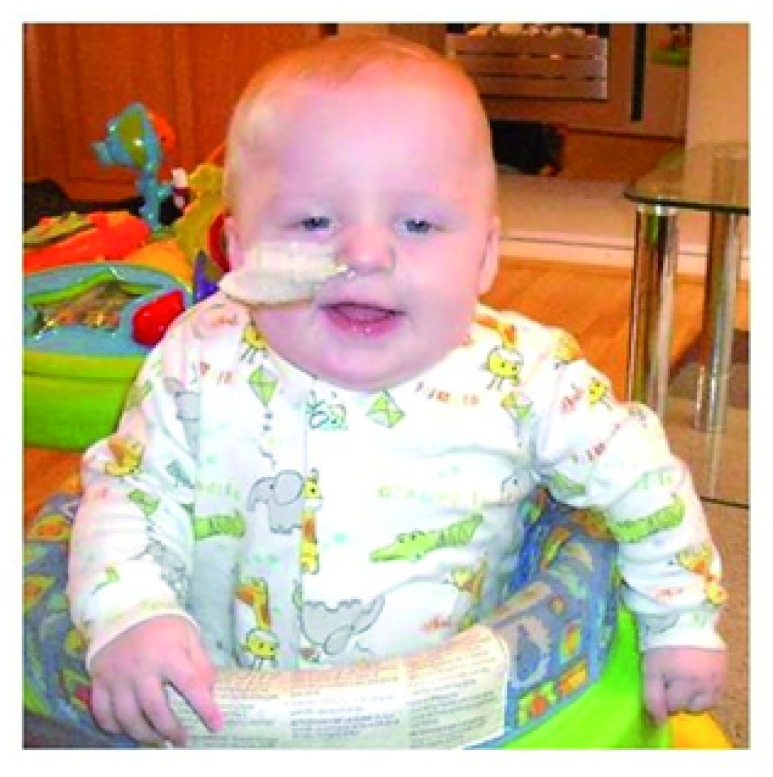
Case C as an infant demonstrating nasogastric tube required for feeding.